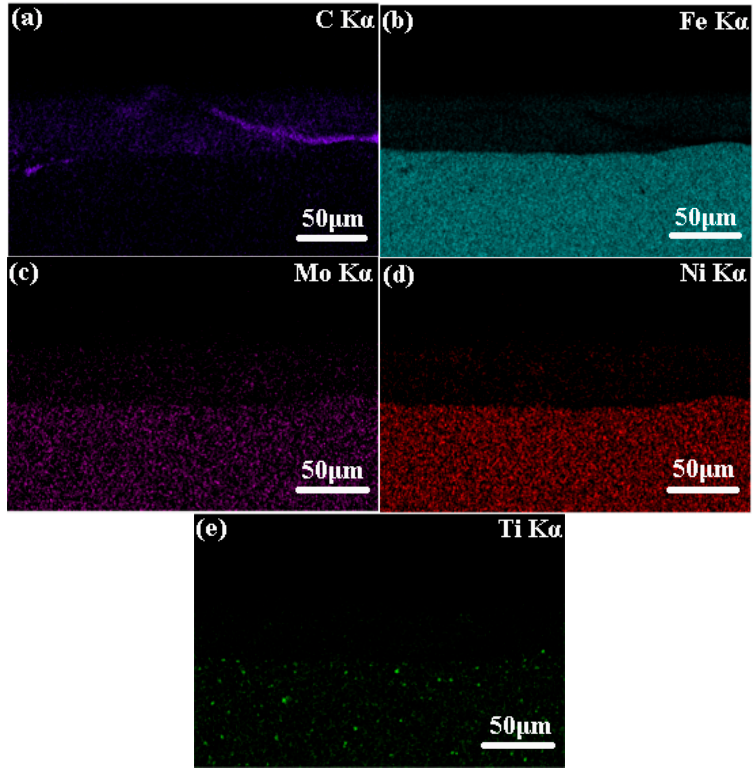
Figure 5. Elemental distribution analysis of the cermet coating. ( a ) distribution of C; ( b ) distribution of Fe; ( c ) distribution of Mo; ( d ) distribution of Ni; ( e ) distribution of Ti.